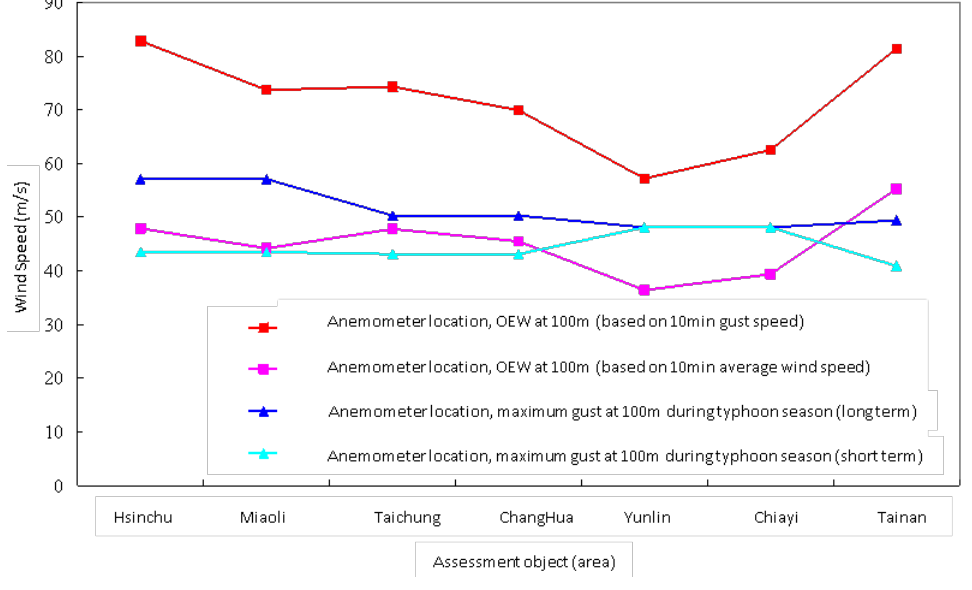
Figure 10. Estimated extreme wind speed and maximum gust wind speed during typhoon